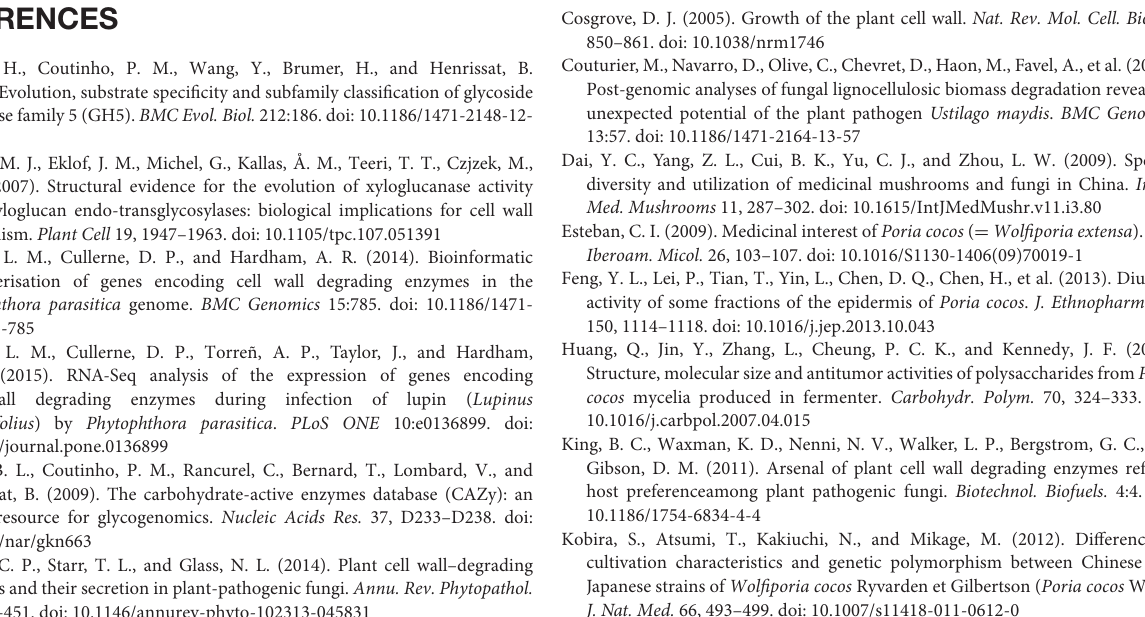
TABLE S1 | Primers for qRT-PCR to verify W. cocos CAZymes genes. TABLE S2 | Differentially expressed carbohydrate-active enzymes (CAZymes) genes between W. cocos mycelium and 2-months-old sclerotium. The up-regulated genes were labeled with yellow fluorescence